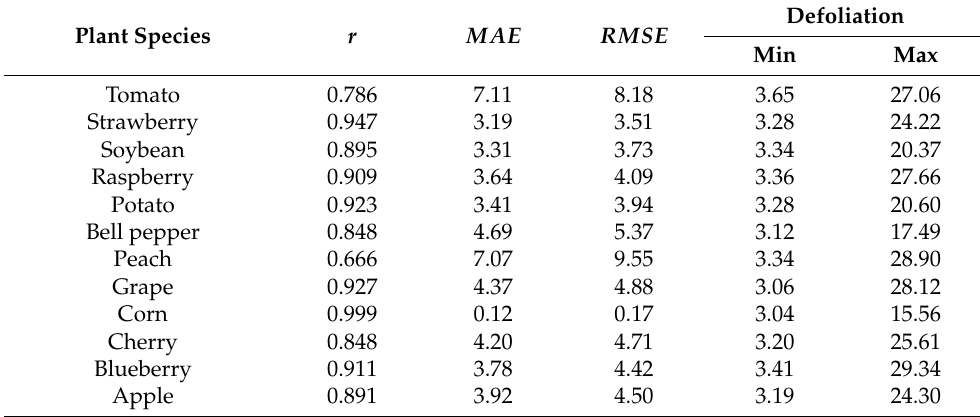
Table 1. Results of our method on different plant species.